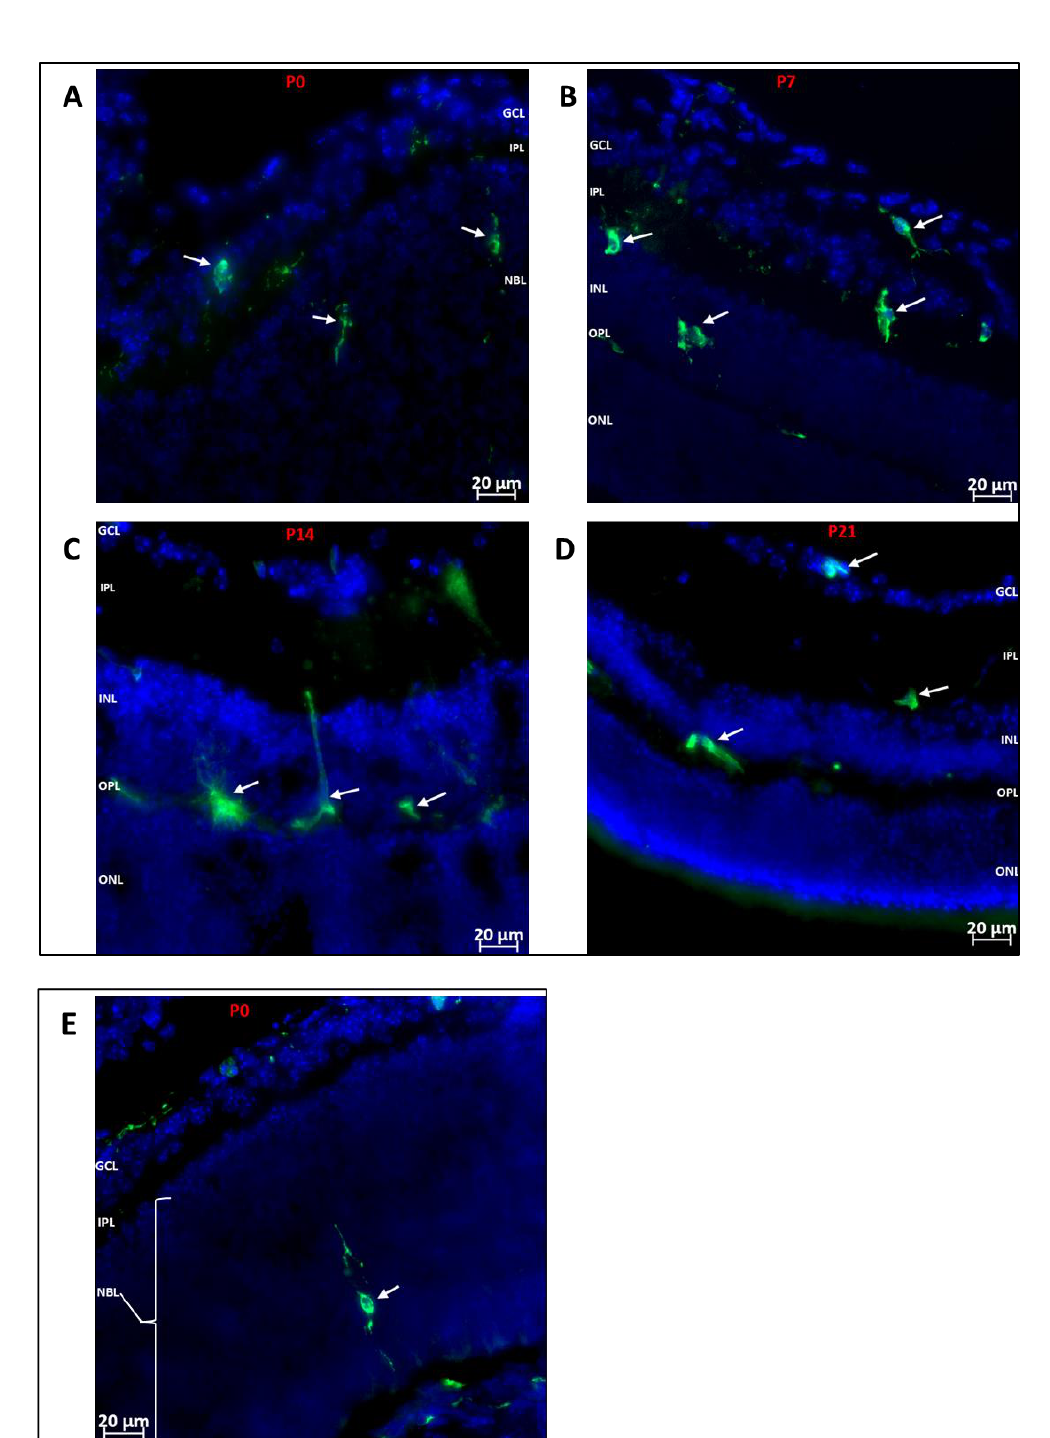
Figure 2. Localization of Hematopoietic Cells in Developing Retina ( A – D ) : Representative images showing localization of GFP + (green) hematopoietic cells in the retina at P0, P7, P14 and P21. The cells predominantly migrate to the inner retina (inner limiting membrane to outer plexiform layer). ( E ): Representative image showing the occasional localization of a hematopoietic cell in the outer retina. A GFP + cell is observed in the developing outer retina extending dendritic processes towards the RPE layer and inner retina. GFP + cells are also observed arriving at the posterior retina via the choroid. Nuclei were stained with DAPI (blue). GCL: Ganglion cell layer; IPL: inner plexiform layer; NBL: neuroblast layer; INL: inner nuclear layer; OPL: outer plexiform layer; ONL: outer nuclear layer.